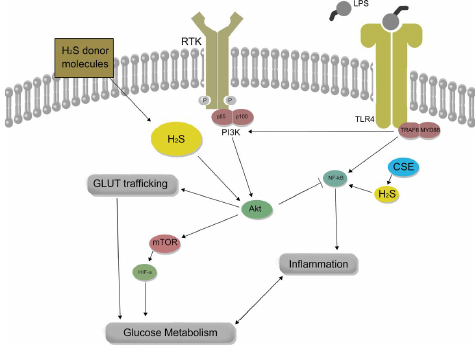
Figure 3. The role of hydrogen sulfide (H 2 S) in macrophage inflammation and glucose metabolism is complex and context-dependent. H 2 S donor molecules can enhance lipopolysaccharide (LPS)-in- duced Akt activity, which may counteract pro-inflammatory NF-κB activity. Conversely, cystathi- onine-γ-lyase (CSE)-derived H 2 S supports NF-κB pro-inflammatory activity, leading to the expres- sion of glucose transporter 1 (Glut1) and metabolic reprogramming in macrophages during inflam- mation. The impact of H 2 S on macrophage inflammation, therefore, depends on factors such as the